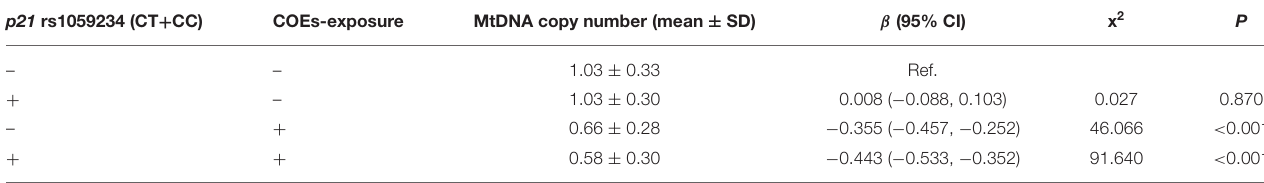
TABLE 4 | Combined effect of p21 rs1059234 and COEs on mtDNA copy number.